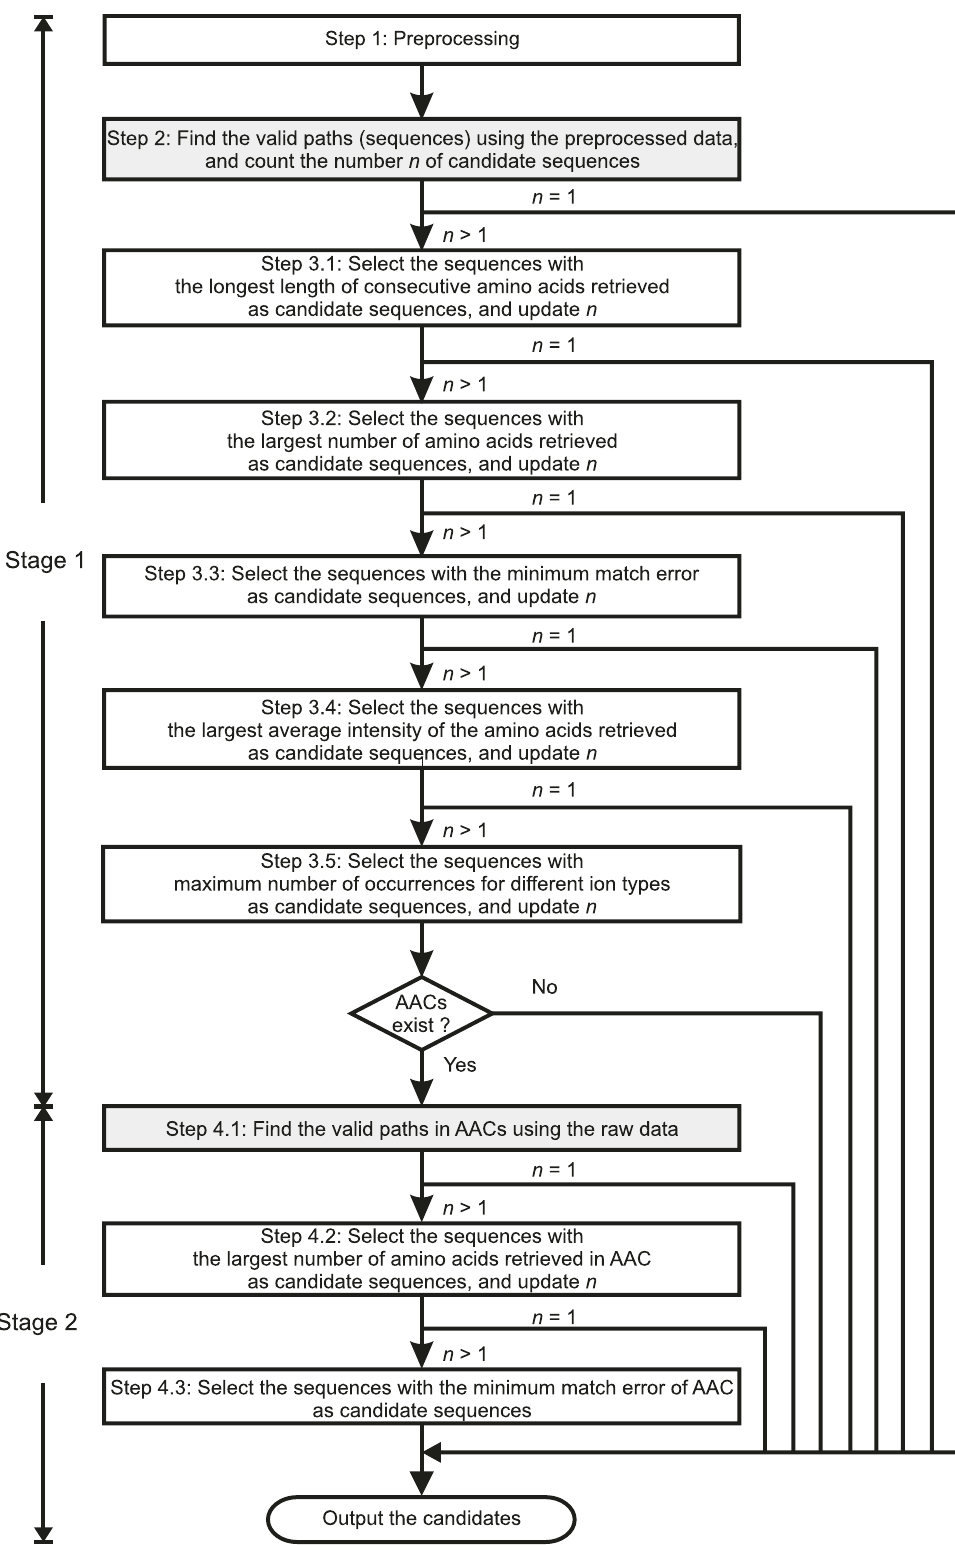
Fig. 5 A fl owchart illustrating the method of two-stage sequencing. AAC stands for amino acid consecutive amino acids retrieved in AACs are selected as candidate sequences (Step 4.2). If there still remain at least two candidate sequences after selection, a fi nal decision is made based on the match error of the amino acids retrieved in AACs for each sequence (Step 4.3).